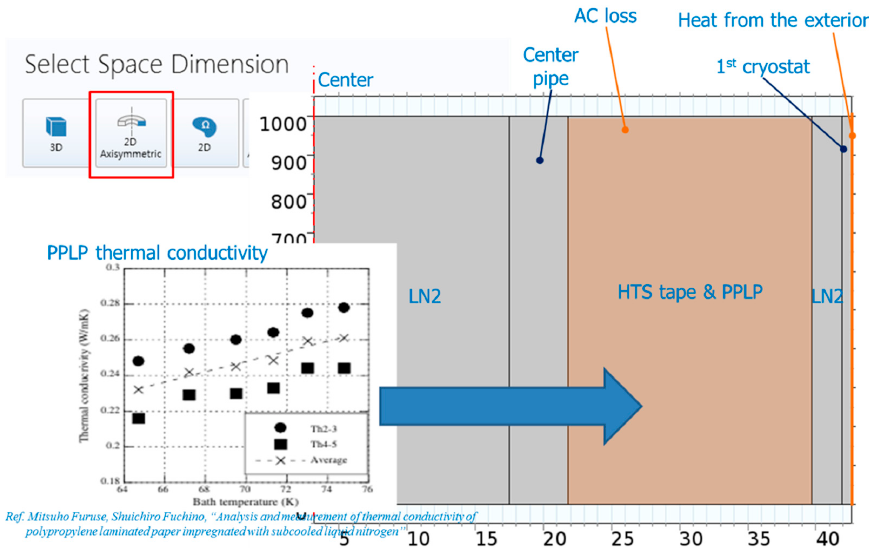
Figure 4. 2D modeling of the thermal analysis of a three-phase coaxial HTS power cable.